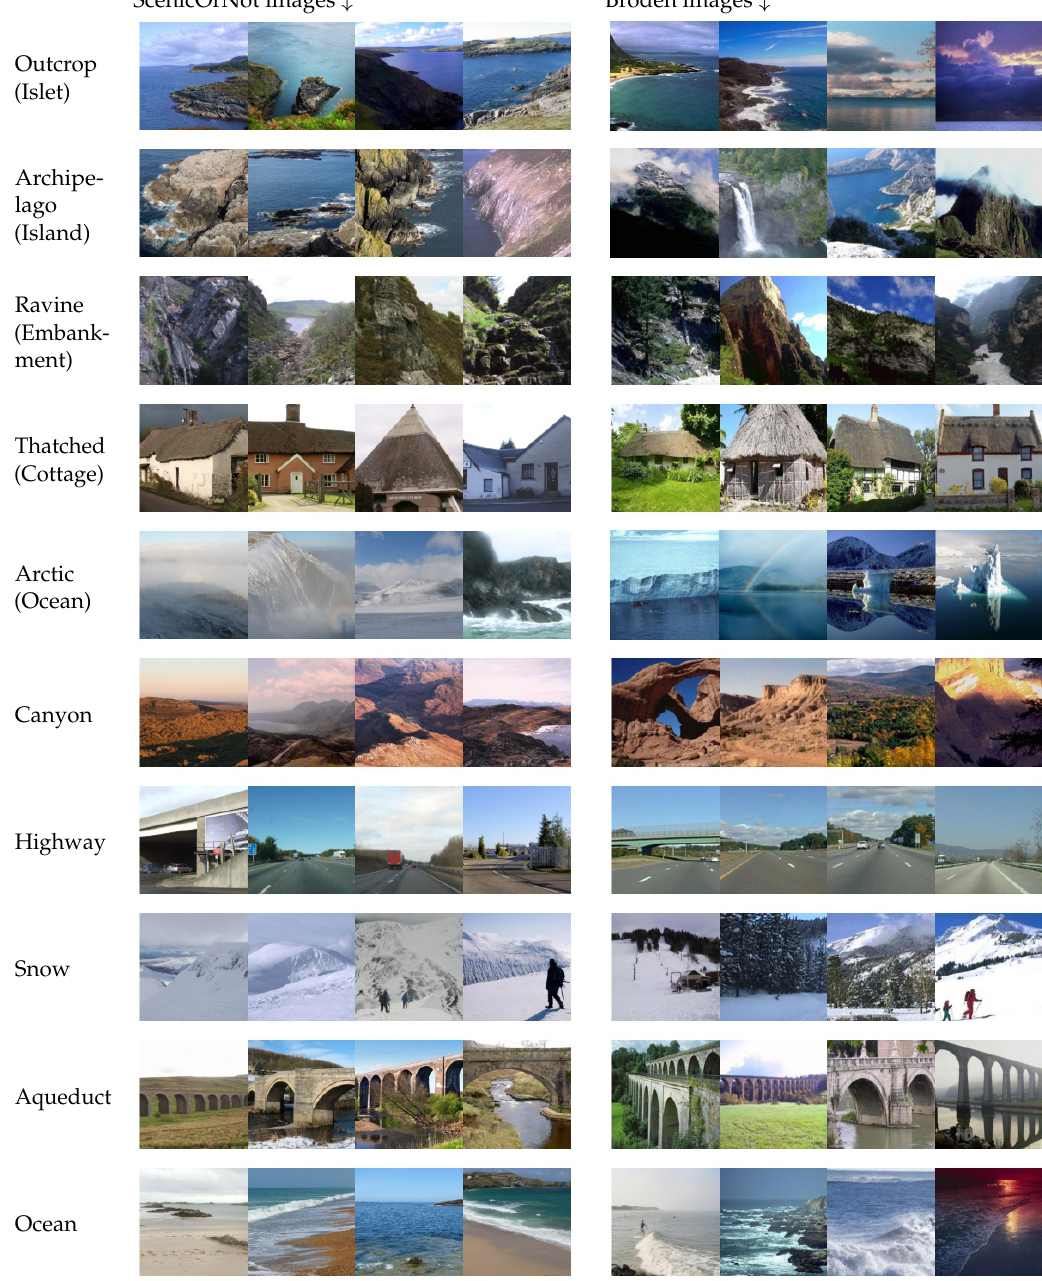
Figure 8. Examples of concepts for which the alignment resulted in clear image representations. For each concept, the left images show the 4 SoN images with the highest concept score in the latent space and the images of the right show the 4 Broden images with the highest corresponding concept score in the latent space. The first five concepts are from GloVe and their training neighbor is shown between parenthesis, the bottom five concepts are training